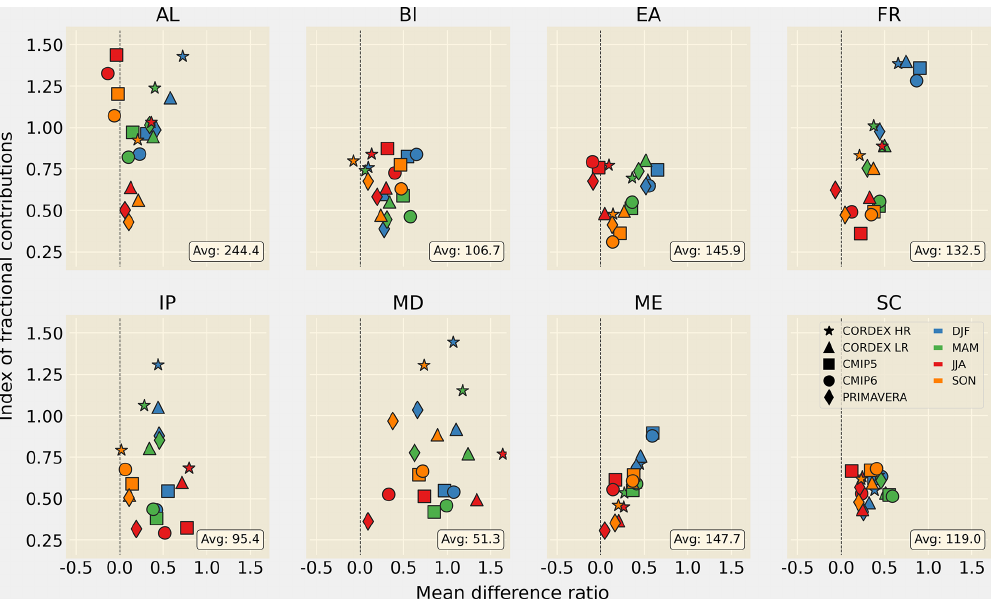
Figure 4. The index of fractional contributions ( y axis) plotted as a function of the fractional difference in seasonal total precipitation ( x axis). E-OBS (0.1 ◦ resolution) is the reference data set, and E-OBS average annual total precipitation (mmyr − 1 ) is shown in lower right in each